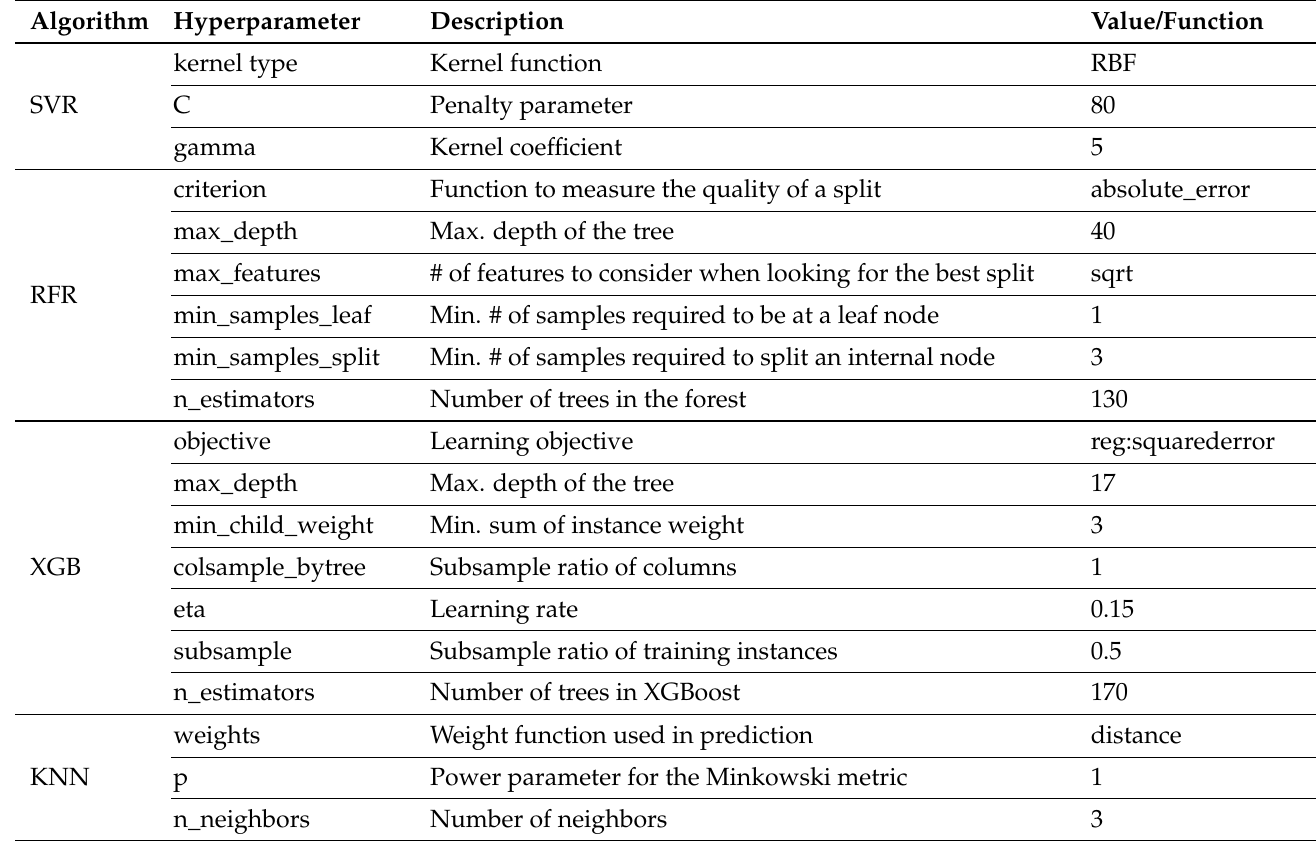
Table 3. The hyperparameters used for the baseline